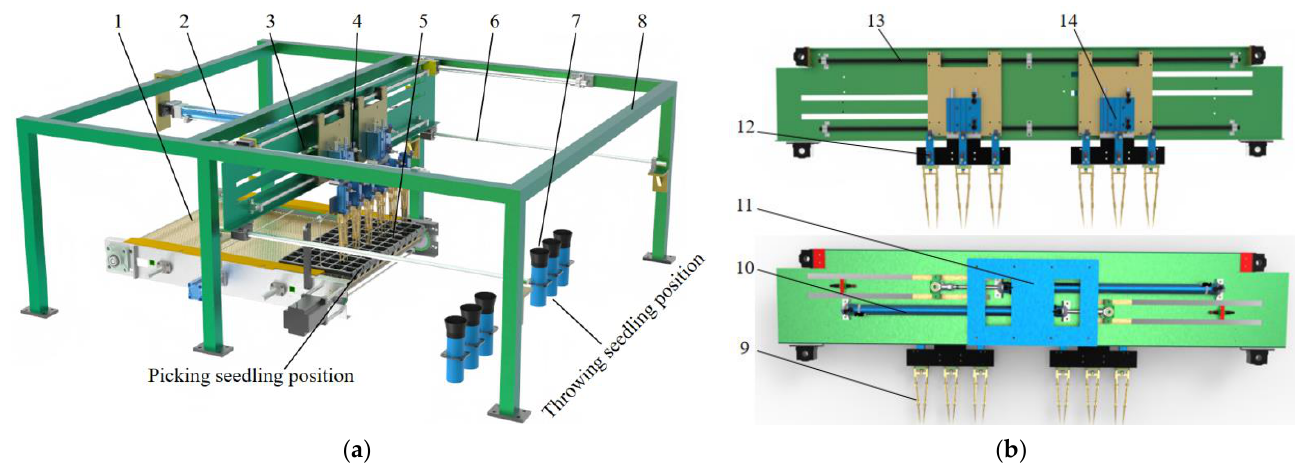
Figure 2. ( a ) The seedling-picking mechanism. ( b ) The seedling-picking executive component. 1. Seedling tray conveying device; 2. longitudinal driving cylinder; 3. seedling-picking installation plate; 4. seedling-picking executive assembly; 5. 72-hole seedling tray; 6. longitudinal linear slide rail; 7. seedling guide tube; 8. seedling-picking frame; 9. seedling claw; 10. horizontal linear cylinder; 11. longitudinal cylinder mounting plate; 12. clamping cylinder; 13. horizontal linear bearing; 14. lifting cylinder.